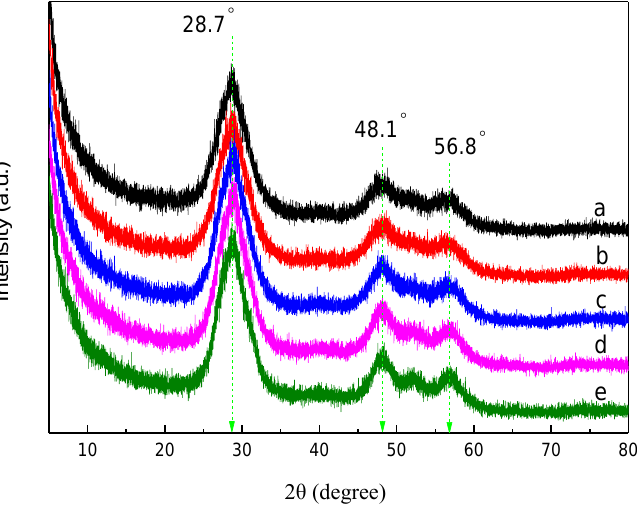
Figure 1. XRD patterns of pure ZnS ( a ), Al-ZnS ( b ), Al-ZG0.6 ( c ), Al-ZG1.2 ( d ) and Al-ZG1.8 ( e ).